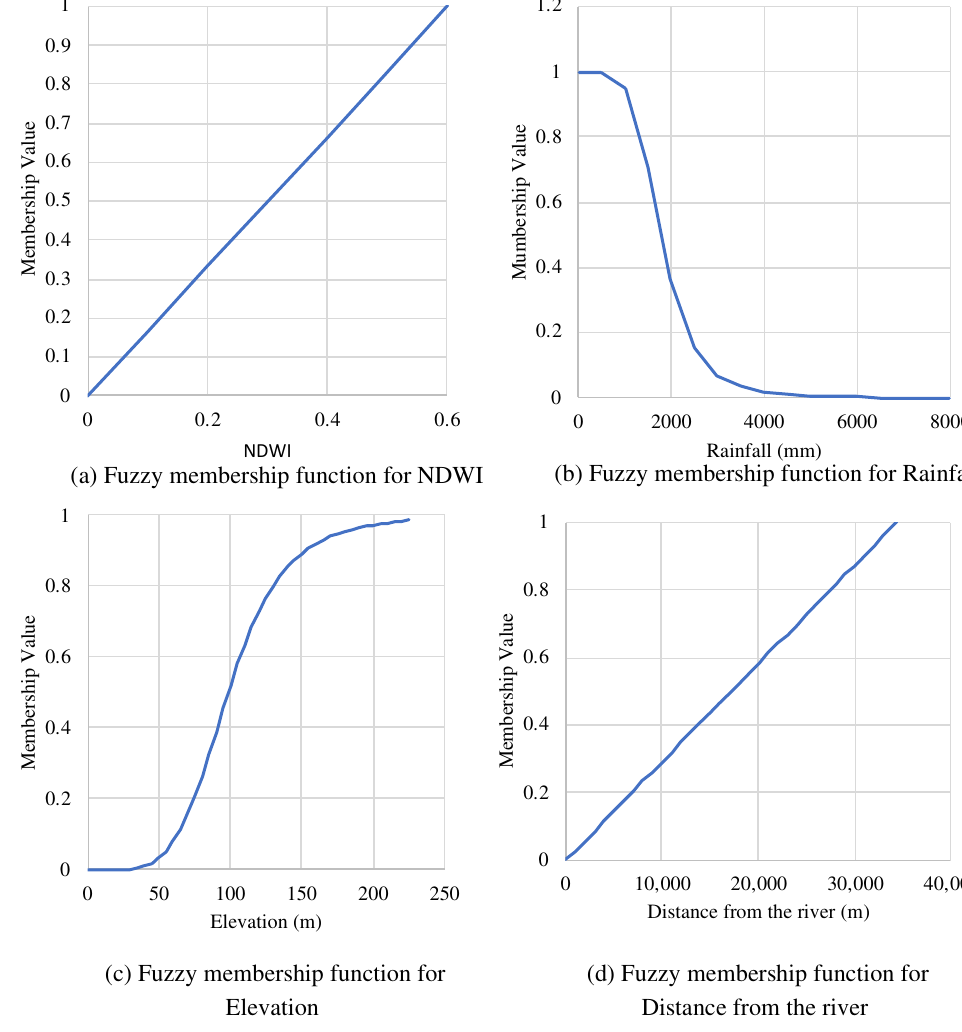
Figure 8. Fuzzy membership functions used for vulnerability analysis of agricultural land use; ( a ) fuzzy linear; ( b ) fuzzy small; ( c ) fuzzy MSlarge and ( d ) fuzzy linear.